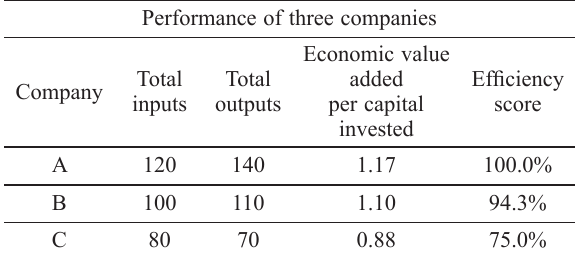
Table 4. Efficiency score example